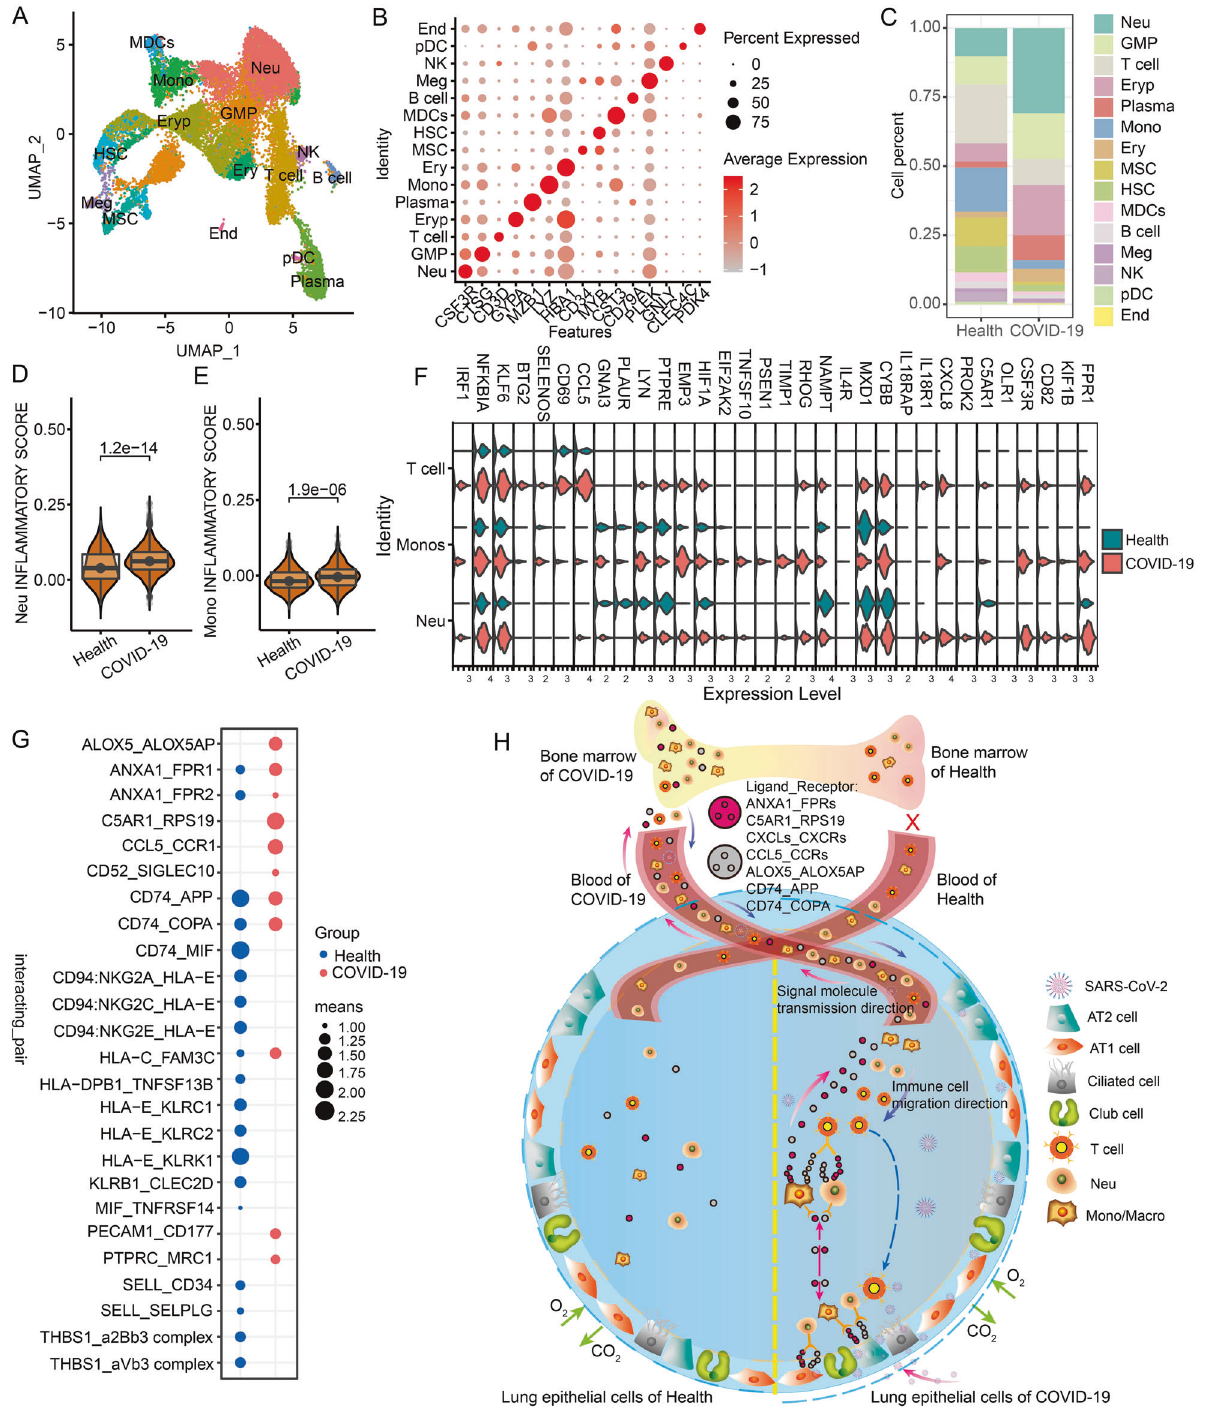
Fig. 6 Single-cell map of bone marrow and its molecular changes. A The UMAP cluster map shows the clustering results of the bone marrow cell types of healthy and COVID-19 patients. B The expression levels of classical marker genes corresponding to different cell types in the bone marrow. C The proportion of different cell types in the bone marrow of the healthy group and COVID-19 patients. D , E Differences in the in fl ammatory gene set scores of bone marrow neutrophils and monocytes in the healthy group and COVID-19 patients. F Signi fi cantly differentially expressed in fl ammation-related genes of bone marrow neutrophils and monocytes in healthy groups and COVID-19 patients. G Receptor and ligand molecules undergo signi fi cant changes between different cell types in the bone marrow. The “ means ” in the legend represent the activity of the cell communication molecule (ligand_receptor). H Ligand/receptor-mediated immune cell migration and antiviral response patterns of lung, blood, and bone marrow. The purple arrows represent the transmission of signaling molecules (ligands/receptors), and the blue arrows represent the migration direction of immune